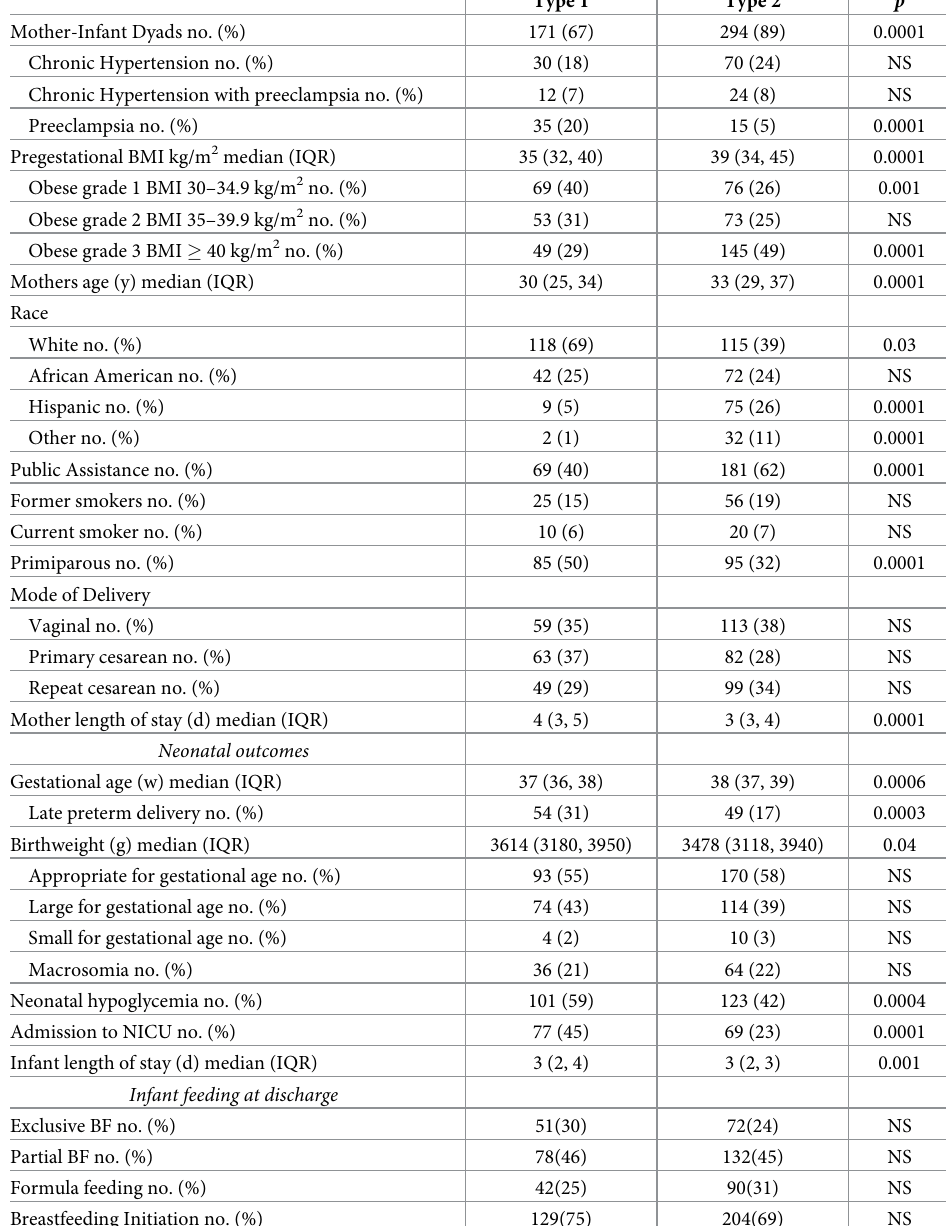
Table 1. Maternal and Neonatal outcomes for women with diabetes and